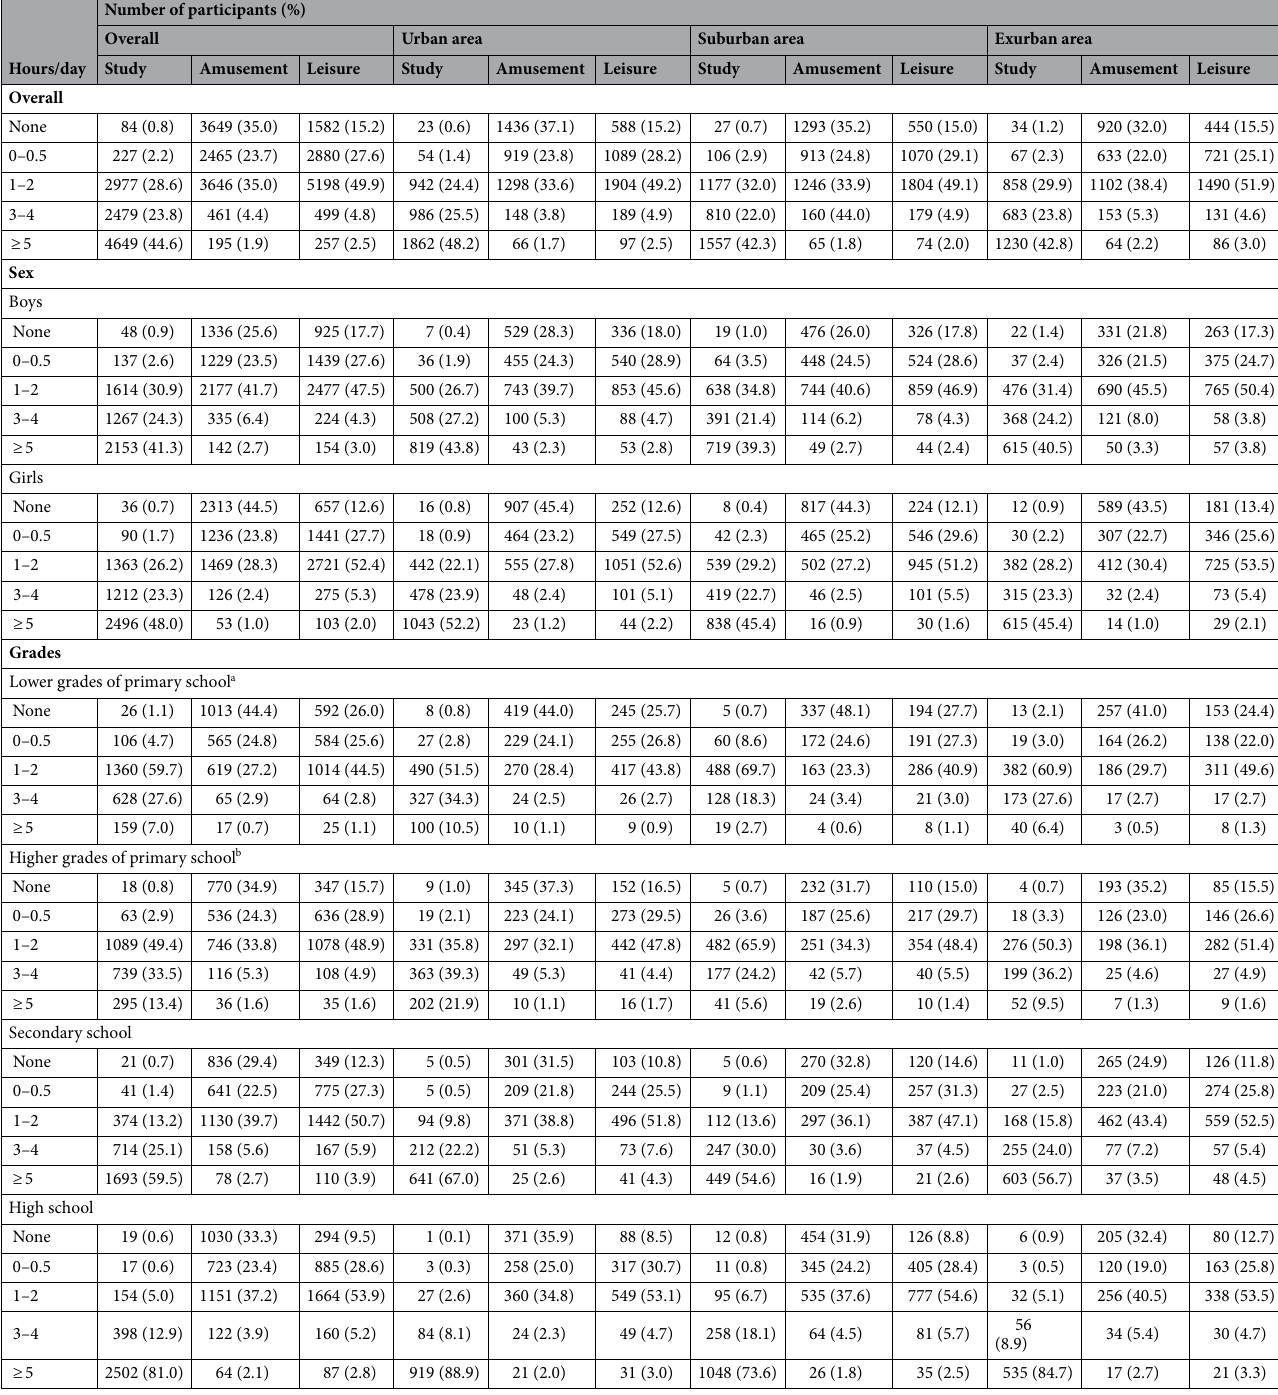
Table 3. Daily screen time for three purposes among students during the COVID-19 pandemic. All data are presented as frequency and its percentage. a Lower grades of primary school: grades 1st to 3rd in